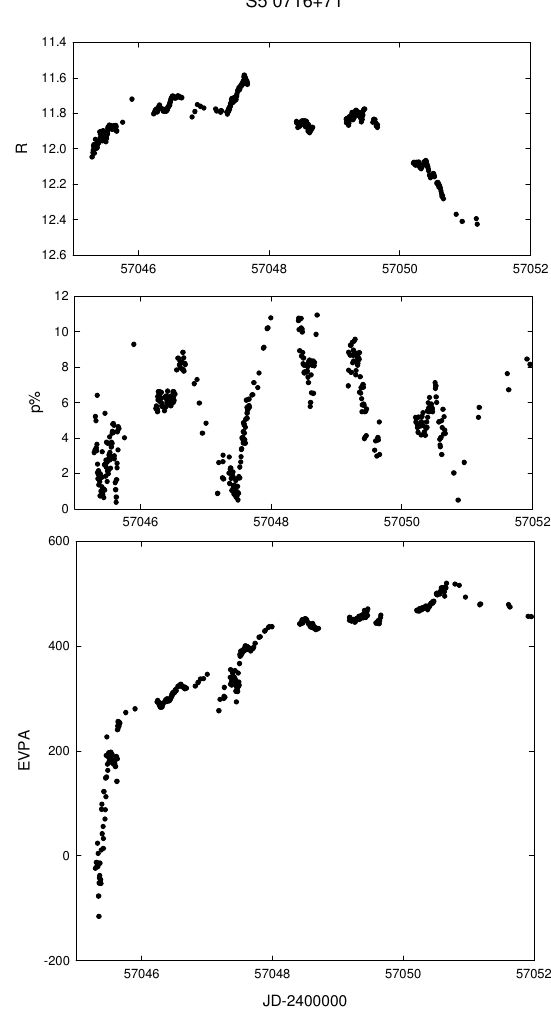
Figure 3. Optical flux evolution, optical fractional polarization, and position angle of polarization of S5 0716+71 during a major outburst in January